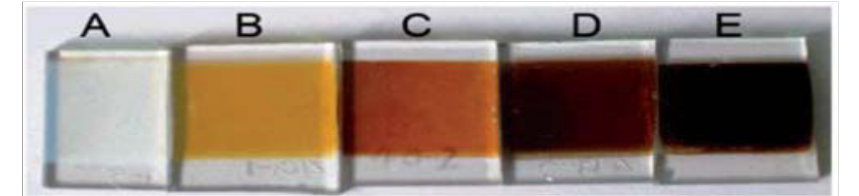
Figure 2. CIS QDs adsorbed onto TiO after heating for 0 s, 30 s, 80 s, and 120 s respectively (Reprinted from [40], by permission of The Royal Society of